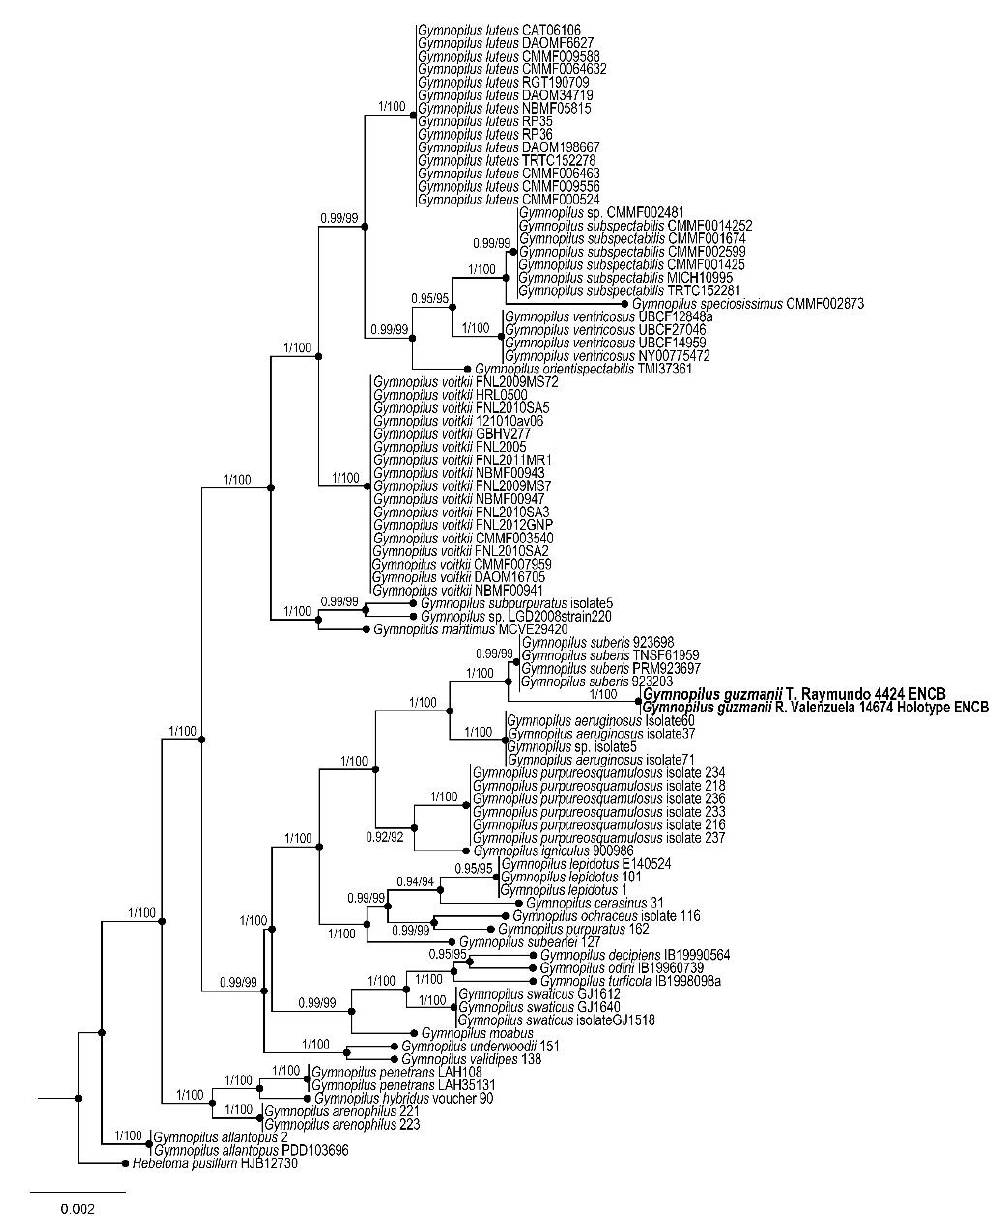
Figure 3. Bayesian inference phylogram of ITS sequences data. Posterior probability ( left of slash) from Bayesian analysis and bootstrap support ( right of slash). The new species Gymnopilus guzmanii is shown in bold. Boldface names represent samples sequenced for this study. Diagnosis: This species is different from other large annulate Gymnopilus species by its basidiomata growing in caespitose clusters on the ground of TMCF with fibrillose- squamulose, yellowish-orange to orange-red pileus and microscopically, basidiospores 7–9 × 5.5–7 µ m, broadly ellipsoid, subreticulate to coarsely roughened with irregular large warts and